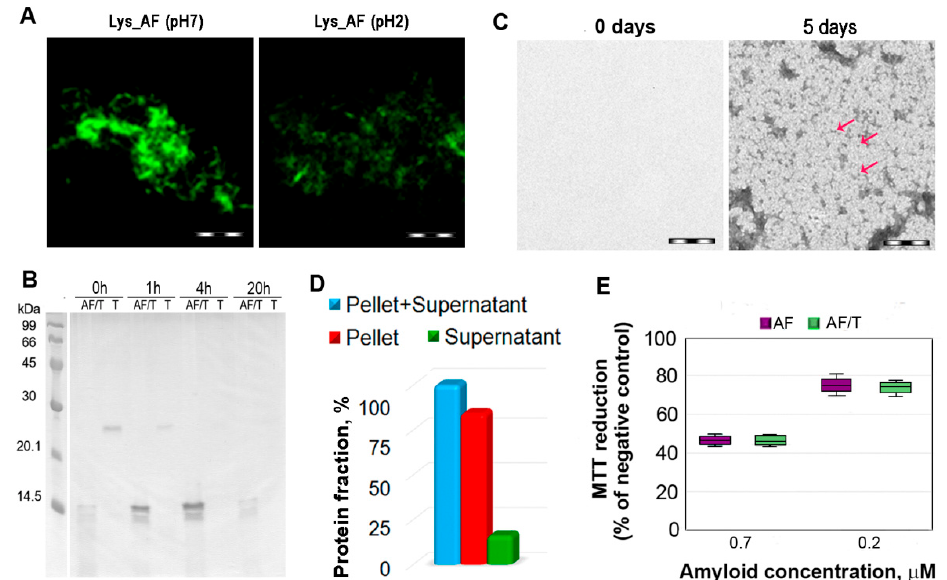
Figure 4. Stability and inhibitory effect on cells of exposed to trypsin amyloid fibrils formed from lysozyme at pH 2. ( A ) The difference in morphology of amyloid fibrils formed from lysozyme at acidic (pH 2) and neutral (pH 7) conditions visualized by confocal microscopy. Scale bars are 3 µ m. ( B ) Trypsin-induced degradation of lysozyme amyloid fibrils detected by SDS-PAGE under denaturing conditions. The amyloid fibrils after the addition of trypsin (AF/T) and trypsin (T) were incubated in PBS at 37 ◦ C, and aliquots were taken at different time points. The molecular weight of lysozyme and trypsin is 14.3 and 23.3 kDa, respectively. ( C ) The electron micrographs of supernatant collected by centrifugation of amyloid fibrils before and five days after the addition of trypsin to the sample. Scale bars are equal to 200 nm. The estimated size of aggregates corresponds to 20 (shown by red arrows) or more monomeric protein molecules as evaluated by ImageJ. ( D ) Redistribution of the protein between supernatant and pellet obtained by centrifugation of amyloid fibrils treated with trypsin. ( E ) Dose-dependent inhibition effect of amyloid fibrils on HeLa cells determined by MTT assay. Cells were exposed to amyloid fibrils, intact (AF) or five days after the addition of trypsin (weight ratio of fibrils to trypsin was kept at 7.5/1) (AF/T), at indicated concentrations for 24 h. Data are expressed as medians and interquartile ranges, and whiskers denote 1.5 × IQR. Experiments were repeated at least three times with similar results.